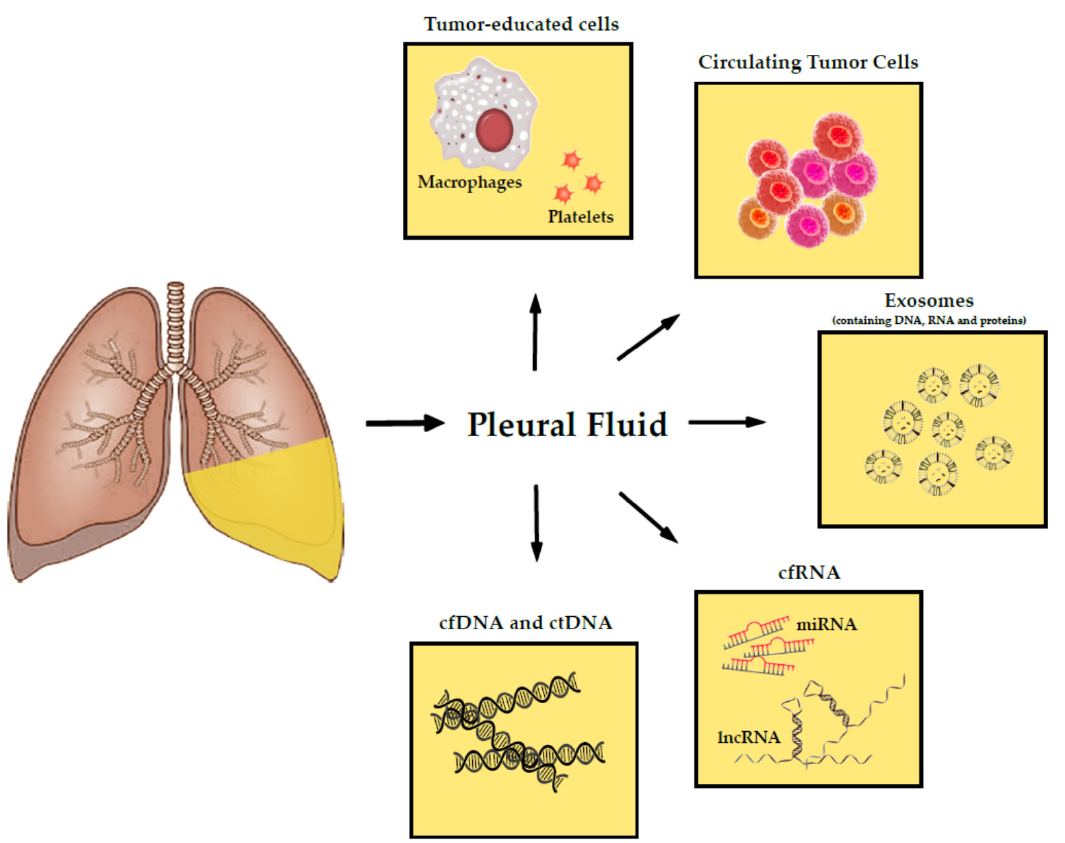
Figure 1. Schematic representation of the foremost tumor-derived products in pleural fluid. Abbreviations: deoxyribonucleic acid (DNA), cell-free DNA (cfDNA), cell-free RNA (cfRNA), circulating tumor DNA (ctDNA), ribonucleic acid (RNA), microRNA (miRNA), long non-coding RNA (lncRNA).